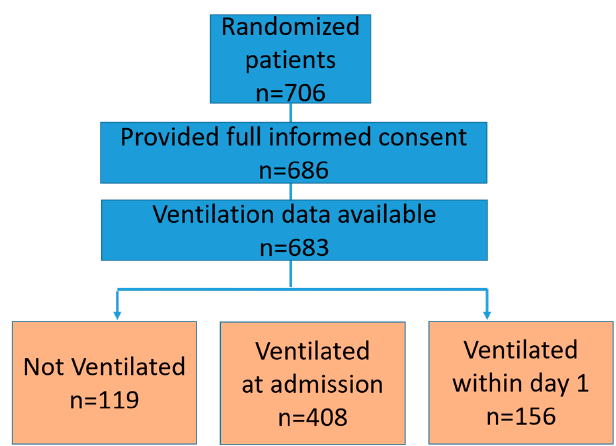
Figure 1. Study flow. Flowchart displaying patients randomized in the study and included in the current analysis. Table 1. Baseline characteristics.